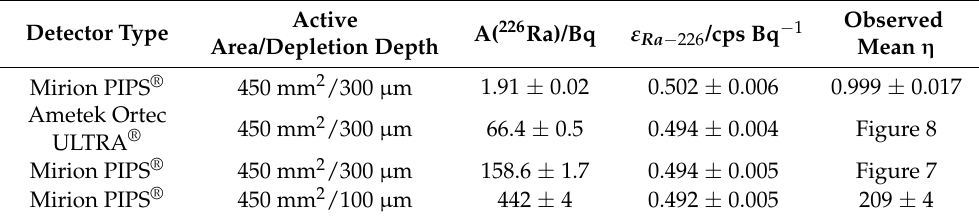
Table 1. Overview over produced